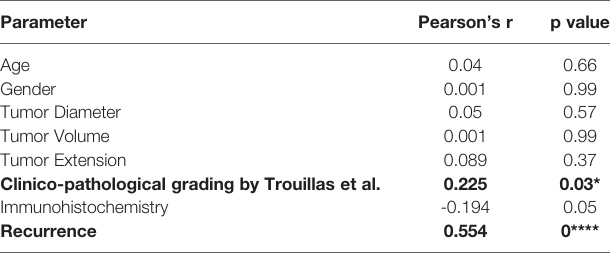
TABLE 2 | Pearson ’ s correlation between tumor characteristics and pEGFR T693 h-score.